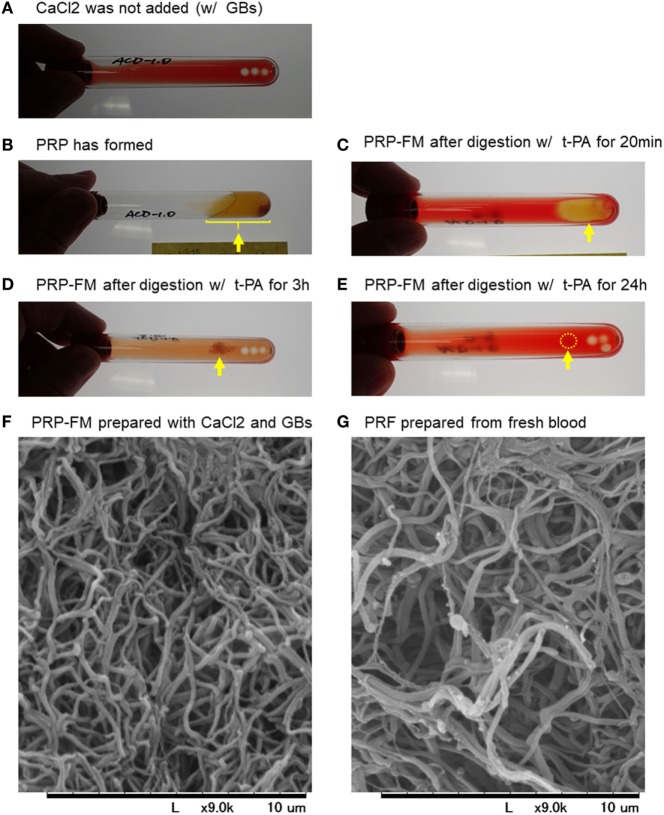
Time-course of degradation images of a platelet-rich plasma (PRP)-FM. The PRP fraction after centrifugation with GBs; CaCl2 was not added (A). The PRP fraction after centrifugation with both GBs and added CaCl2. The PRP-FM has formed (B). The PRP-FM after digestion with tissue-plasminogen activator (t-PA) for 20 min (C), 3 h (D), and 24 h (E). Abbreviation: GBs, glass beads. Arrows indicate the remaining PRP-FM. Surface microstructures of PRP-FM (F) and platelet-rich fibrin (PRF) (G). Similar observations were obtained from other three independent blood samples.